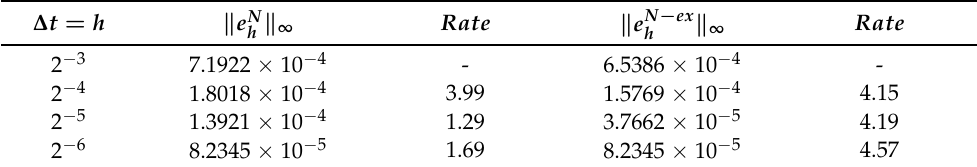
Table 4. Error behaviors and rate for the Crank-Nicolson scheme and exact solution for Example 2 with α = 0.8 at time T = 1.